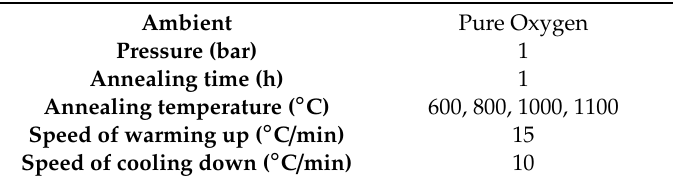
Table 2. Conditions of annealing